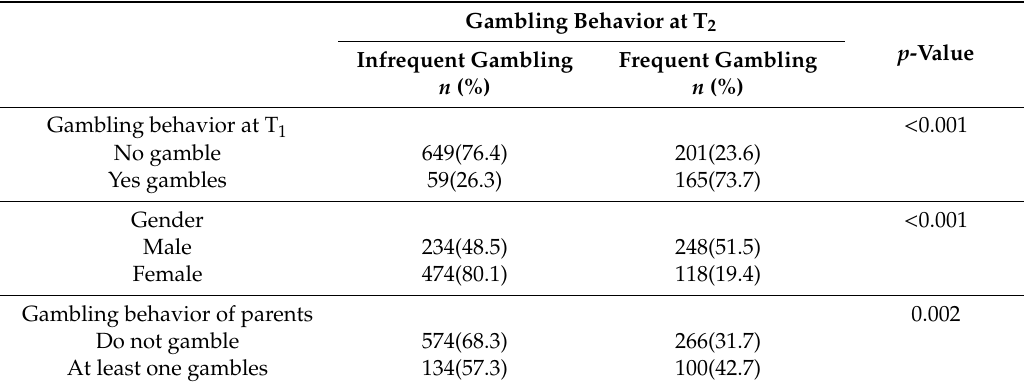
Table 3. Distribution for gambling behavior at T 2 compared to T 1 and p -value according to chi-squared.